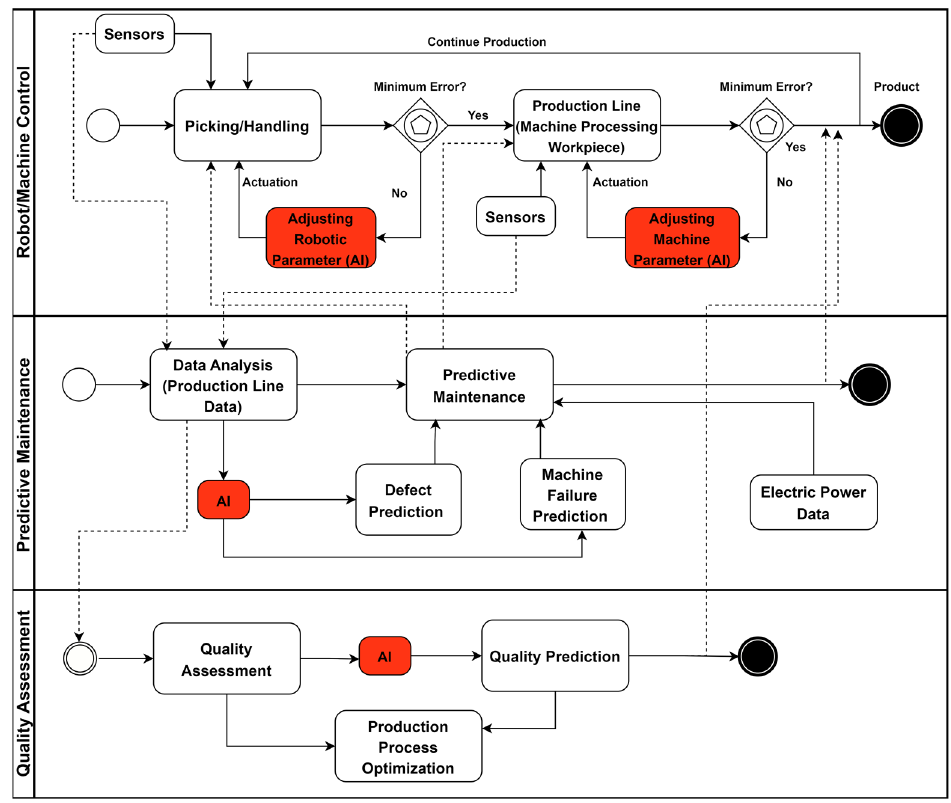
Figure 6. BPMN model “exploding” Industry 5.0 processes and correlations between robot/machine control, predictive maintenance, and quality assessment. Table 7. Framework limitations and perspectives to overcome these limitations.